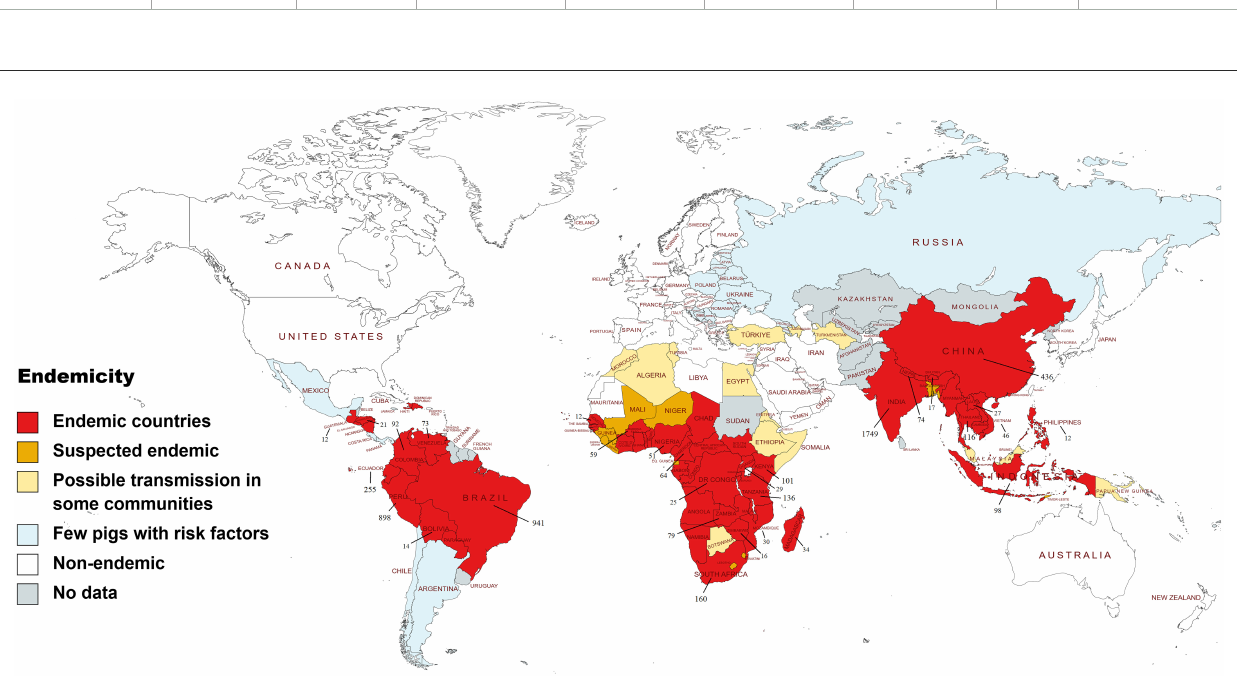
FIGURE2 Research on cysticercosis and neurocysticercosis from countries where T. solium is endemic included in the MEDLINE database ( > 10